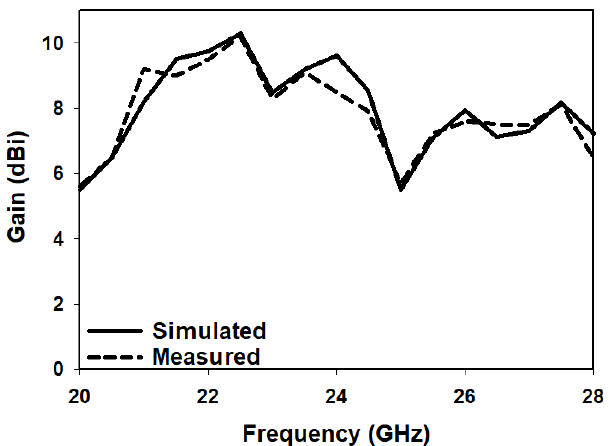
Figure 6. The gain of a hemispherical DRA with an outlined position on the ground plane.